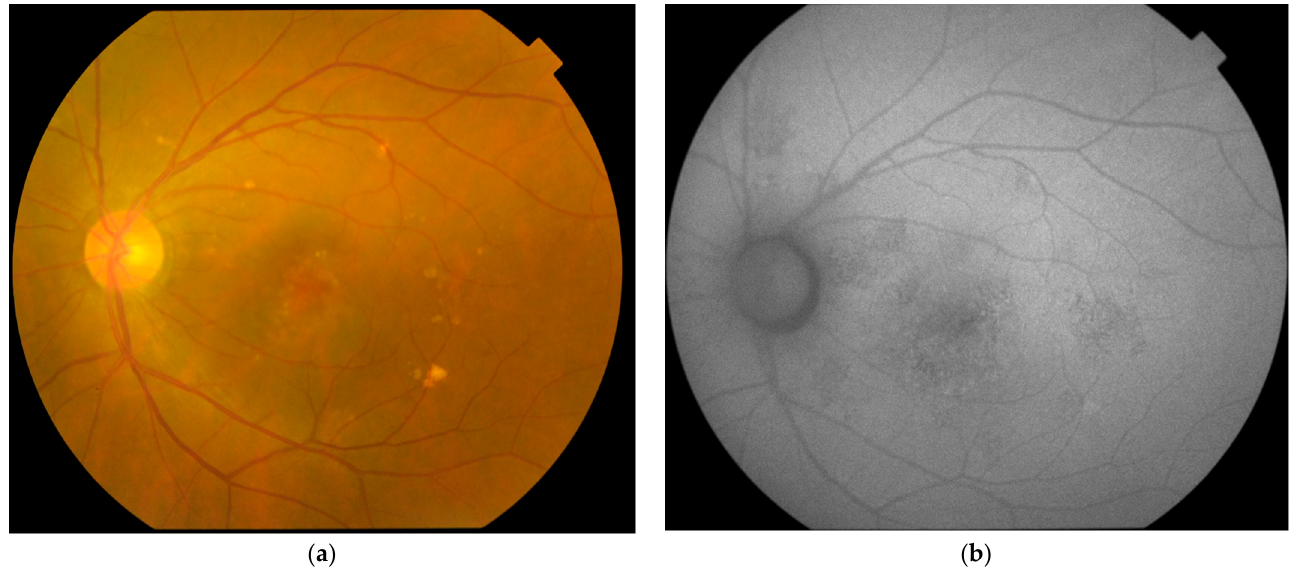
Figure 1. ( a ) Fundus photograph of a 69-year-old patient with central serous chorioretinopathy showing multiple pachydrusen in the inferiotemporal and temporal macula occurring as a cluster and scattered in the superior macula around the vascular arcade; ( b ) fundus autofluorescence showing mixed increased and reduced autofluorescence of ≥ 2 disc areas scattered in the macula due to widespread dysfunction of the retinal pigment epithelium.